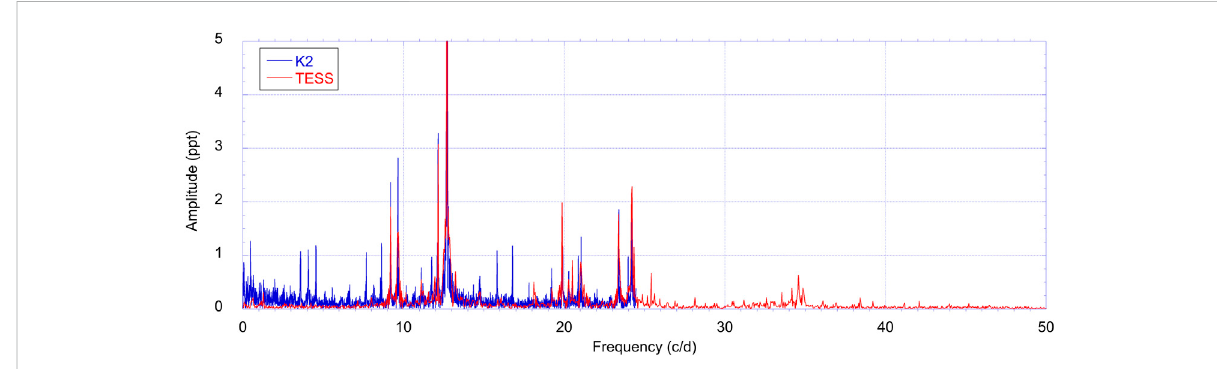
FIGURE 5 FG Vir K2 and TESS amplitude spectra overlayed. The amplitude axis has been truncated at 5 ppt to show the low-amplitude